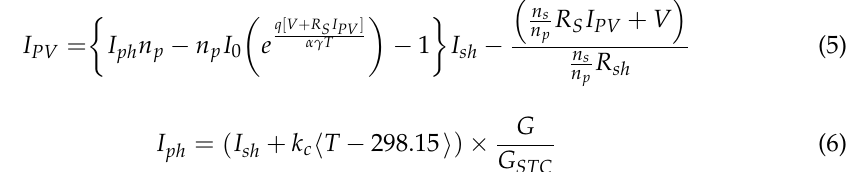
output voltage and current of the solar PV array may be increased to suit the conditions and requirements. The I – V characteristics of a solar arrays are expressed in Equation (5), in which 𝑛 𝑠 is the number of solar cells in series, and 𝑛 𝑝 is the number of solar cells in parallel.